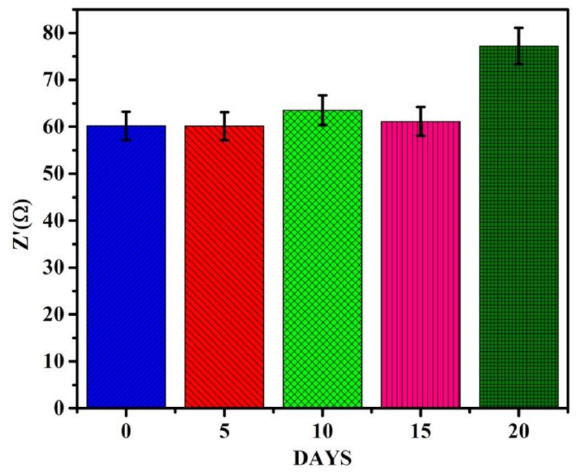
Figure 5. Stability and shelf-life study indicating a stable lifetime of 15